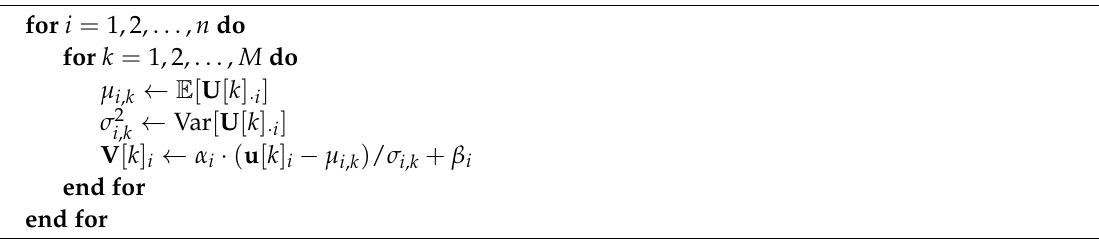
Algorithm 1 Forward Pass of Multi-stream AdaBN in the traning